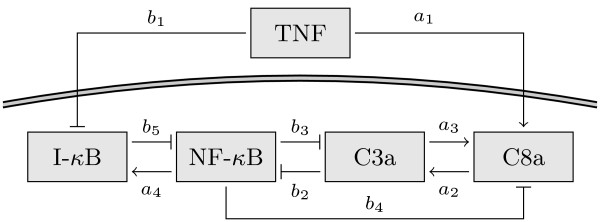
Graphical representation of the TNF signal transduction model. Normal arrows indicate activation while arrows with flat hats indicate inhibition.